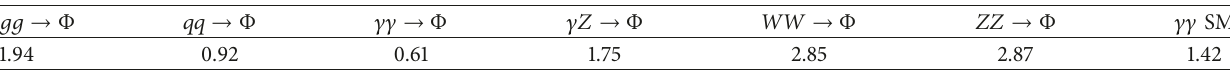
Table 1: Average jet multiplicity for different production modes of Φ at the 13 TeV LHC with L = 50 fb −1 . Average jet multiplicity is defined by the sum, ∑ 𝑖 ( BH ) 𝑖 𝑁 𝑖 where BH 𝑖 represents the bin height of the 𝑖 th bin of the normalized 𝑁 jet distribution and 𝑁 𝑖 = 𝑖 − 1 is the number of jets associated with the 𝑖 th